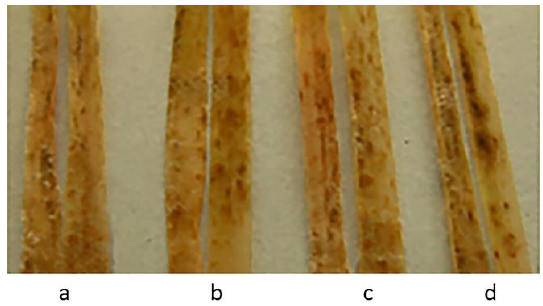
Figure 5. SNB development on seedlings of wild wheat species samples from the VIR collection after infection with a mixture of S. nodorum isolates: ( a ) T. urartu k-58497; ( b ) T. urartu k-66361; ( c ) T. boeoticum k-58506; and ( d ) T. boeoticum k-59178.